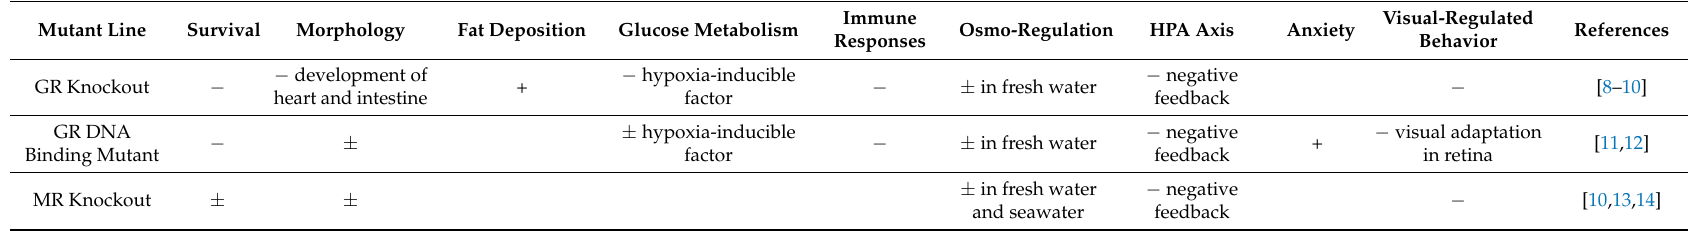
Table 1. Phenotypic consequences including those associated with nutrition dysregulation in constitutive knockouts of glucocortoid receptor (GR) and mineralocorticoid receptor